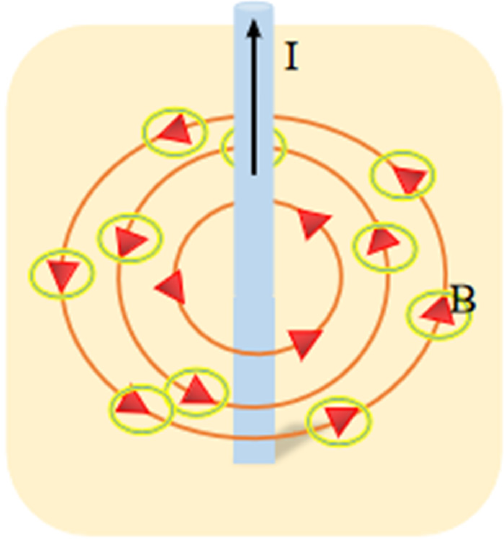
Figure 8. An illustration of electromagnetic induction.